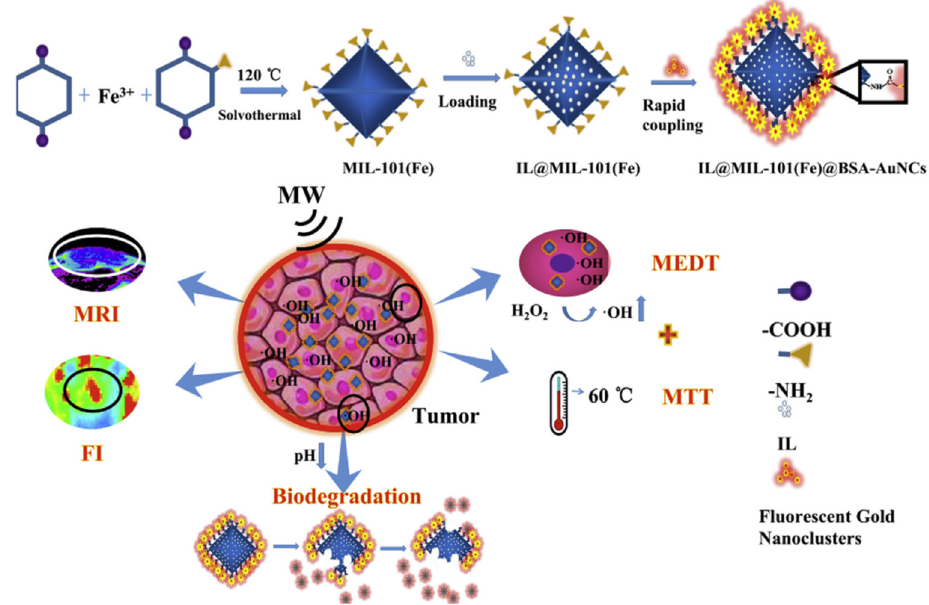
Figure 2. The synthesis schematic of multifunctional nanomaterials (IL@MIL-101(Fe)@BSA-AuNCs NPs), and its integrated diagnostic and therapeutic applications [71].